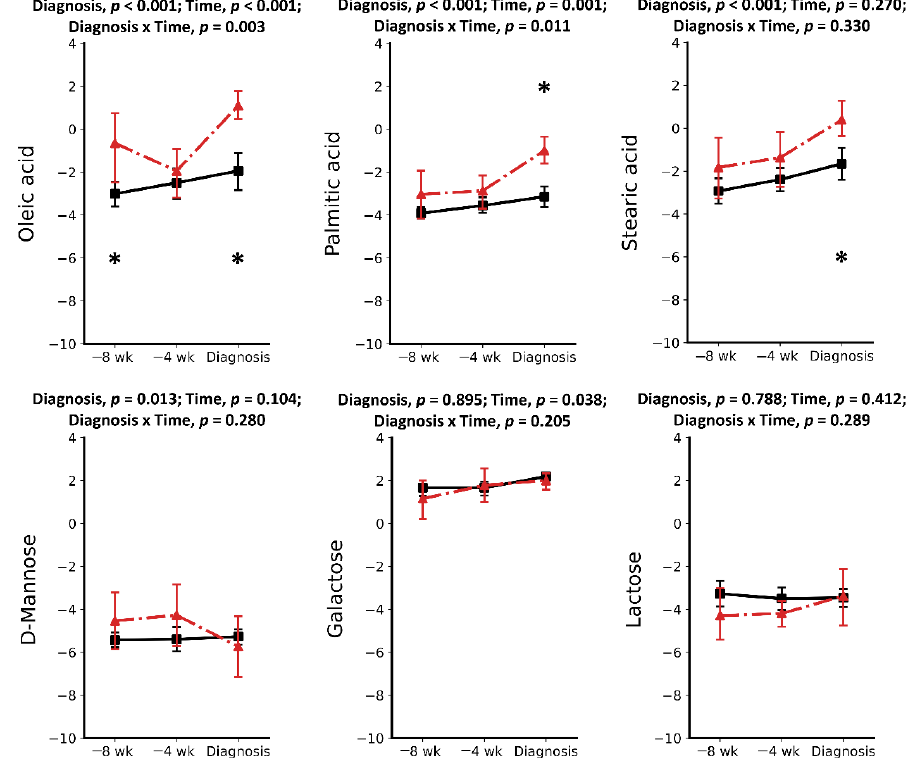
Figure 3. Concentrations of organic acids and carbohydrates in the serum of healthy cows (solid line) and pre-retained placenta or retained placenta (dashed) cows. Asterisk (* p < 0.05) indicates significant differences between groups at − 8 and − 4 weeks prepartum and at the week of retained placenta diagnosis. Results are presented in log2. Table 2. Concentrations of altered serum metabolites [mean(SD)] in healthy controls (CON) and pre-retained placenta (Pre-RP) cows at −4 weeks pre-partum as determined by GC/MS. Metabolite. mM